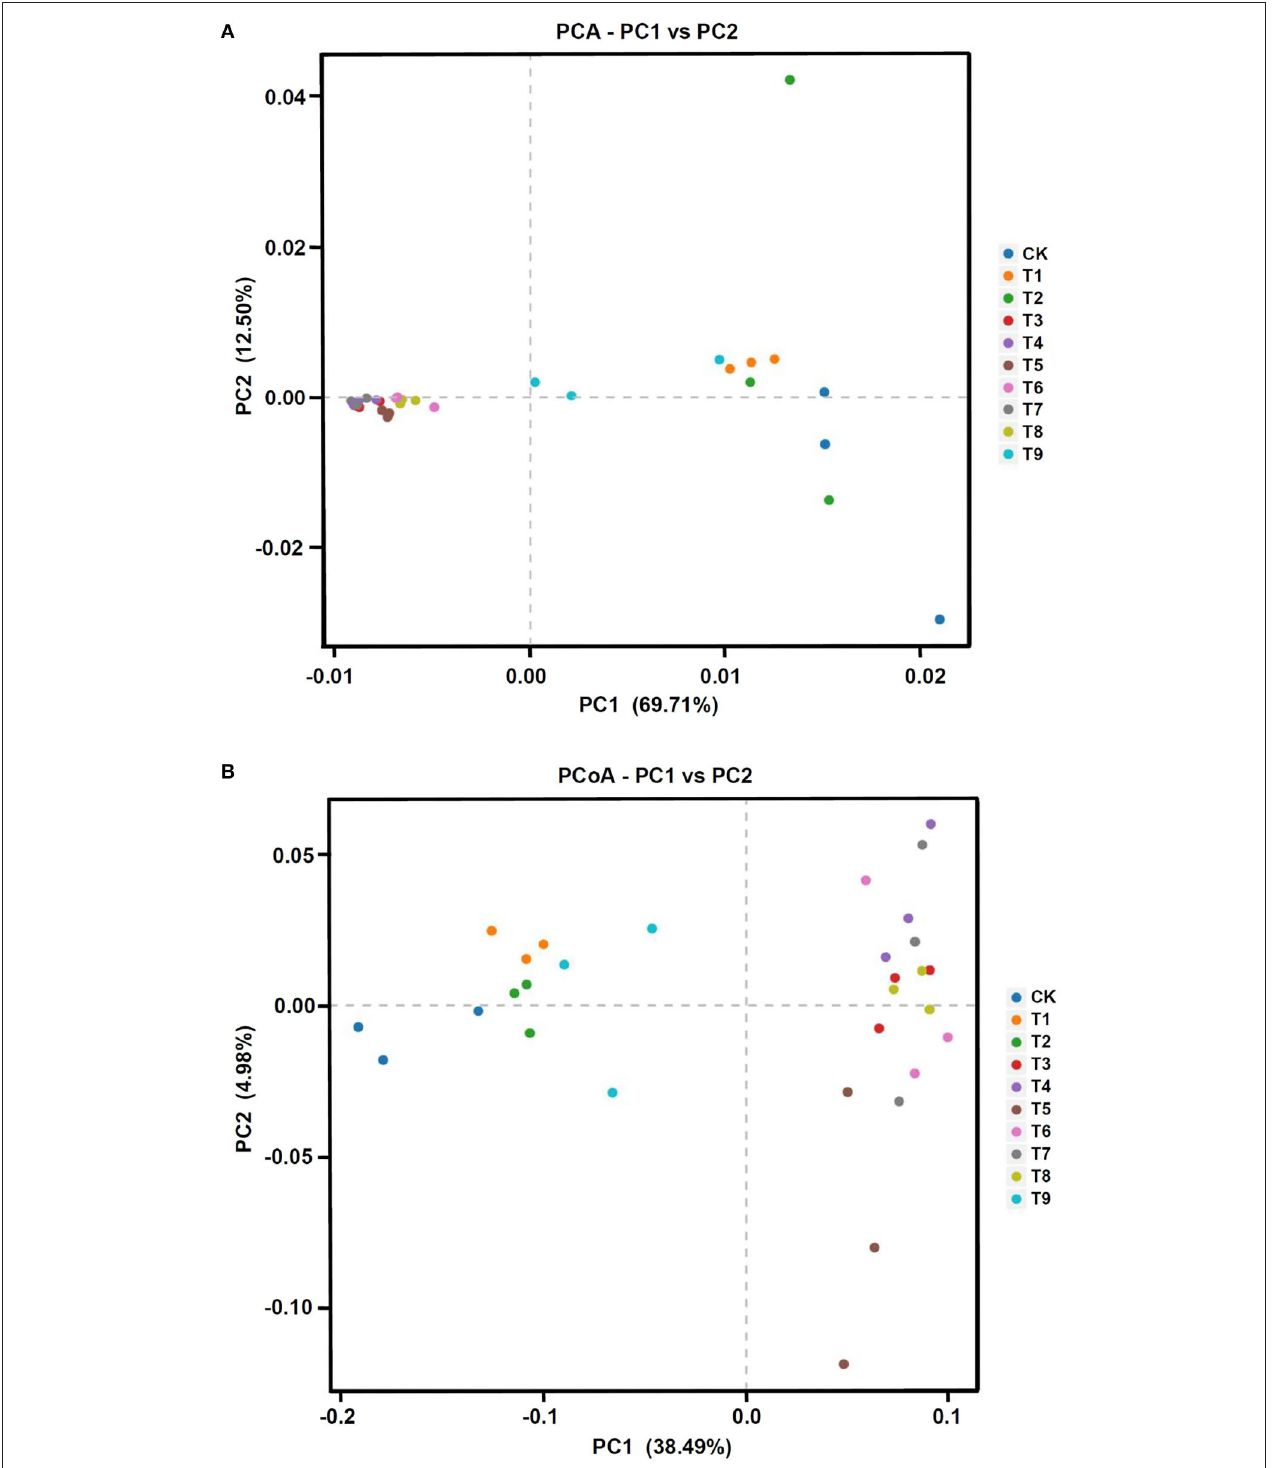
FIGURE 5 | Fungal community structure in ginseng rhizosphere soil in different NPK fertilization treatments. (A) Principal component analysis (PCA) and (B) principal coordinate analysis (PCoA) of fungal communities based on operational taxonomic units. Note: (a) Composition of fertilization treatments: CK, N 0 P 0 K 0 ; T1, N 1 P 1 K 1 ; T2, N 1 P 2 K 2 ; T3, N 1 P 3 K 3 ; T4, N 2 P 1 K 2 ; T5, N 2 P 2 K 3 ; T6, N 2 P 3 K 1 ; T7, N 3 P 1 K 3 ; T8, N 3 P 2 K 1 ; T9, N 3 P 3 K 2 .